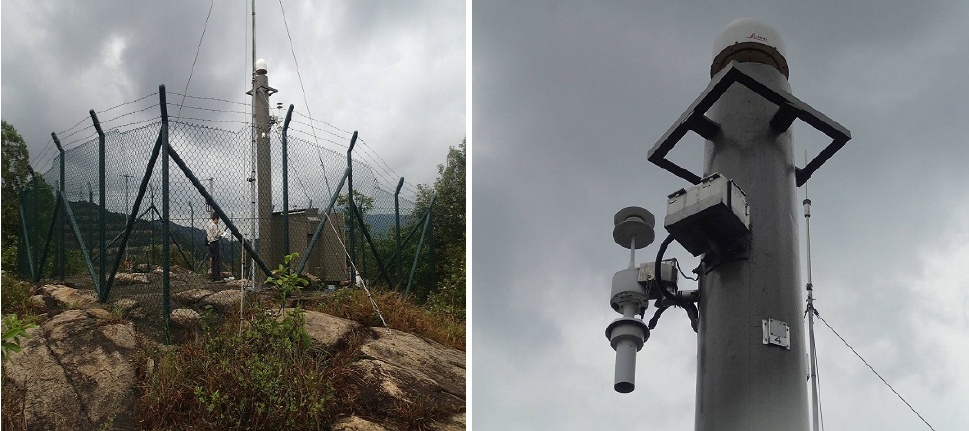
Figure 2. Photographs of the HKLT (Hong Kong Lam Tei) station obtained from the website of Geodetic Survey of Hong Kong.